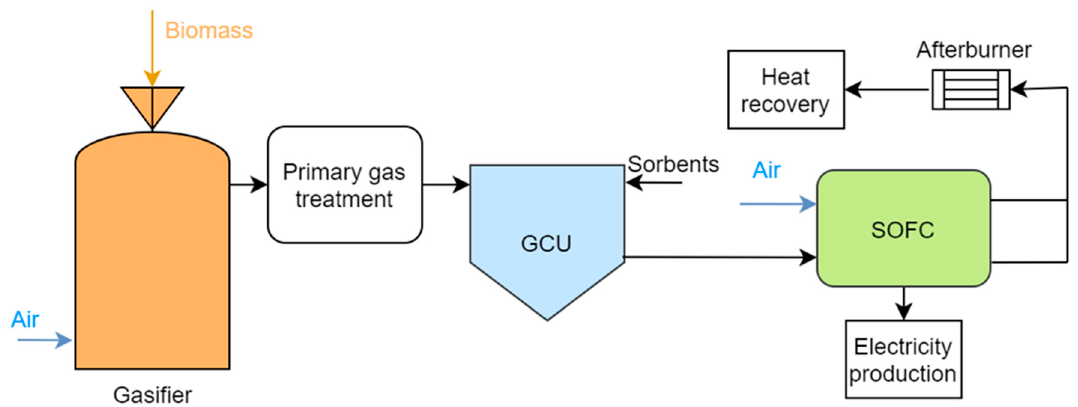
Figure 1. Concept of high-efficiency bio-based power (HBP) technology. GCU = Gas cleaning unit. SOFC = Solid oxide fuel cell.